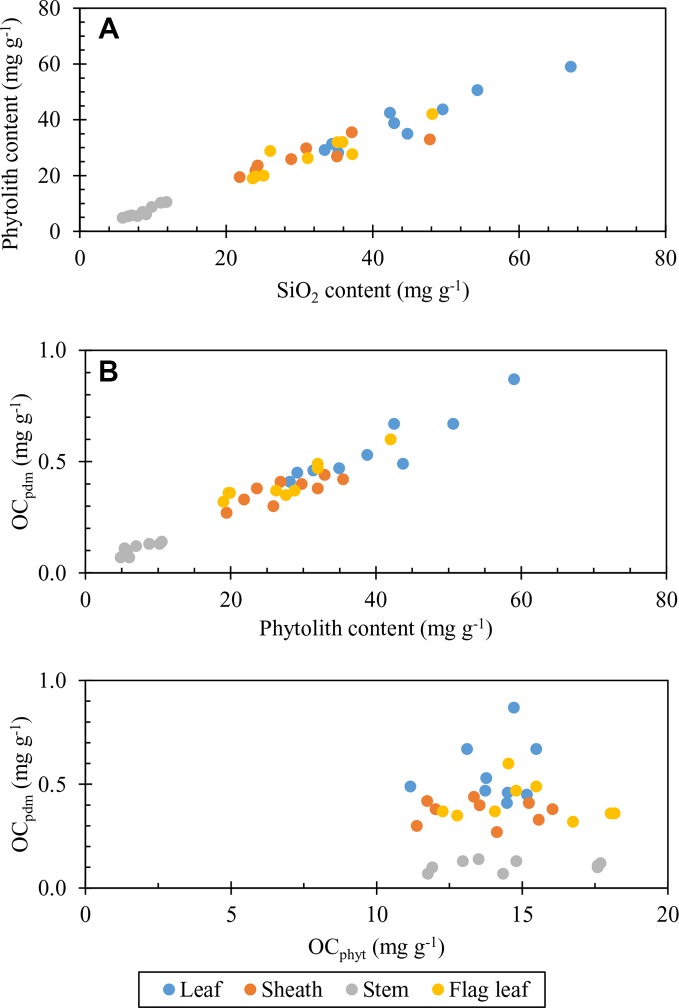
Plot of: (A) phytolith content of plant parts against SiO2 content considering all silicon-phosphorus (Si-P) treatments (leaf: y = 0.9151x−1.2668, R2 = 0.9254 P < 0.01; flag leaf: y = 0.8248x + 1.3865, R2 = 0.8035 P < 0.01; Sheath: y = 0.5457x + 10.337, R2 = 0.6938 P < 0.01; Stem: y = 1.0171x−1.6823, R2 = 0.8929 P < 0.01). (B) OCpdm content of plant parts against phytolith content considering all Si-P treatments (leaf; y = 0.0134x + 0.0233, R2 = 0.8557 P < 0.01; flag leaf; y = 0.011x + 0.1038, R2 = 0.8097 P < 0.01; sheath; y = 0.008x + 0.1541; R2 = 0.6845 P < 0.01; stem; y = 0.0121x + 0.0166; R2 = 0.7924 P < 0.01). (C) OCpdm content of plant parts against C content of phytoliths (OCphyt) considering all Si-P treatments (leaf; y = 0.019x + 0.29, R2 = 0.0273 P > 0.05; flag leaf; y = −0.0079x + 0.5291; R2 = 0.0329 P > 0.05; sheath; y = −0.003x + 0.4191; stem; y = 0.0027x + 0.0629; R2 = 0.0491 P > 0.05).